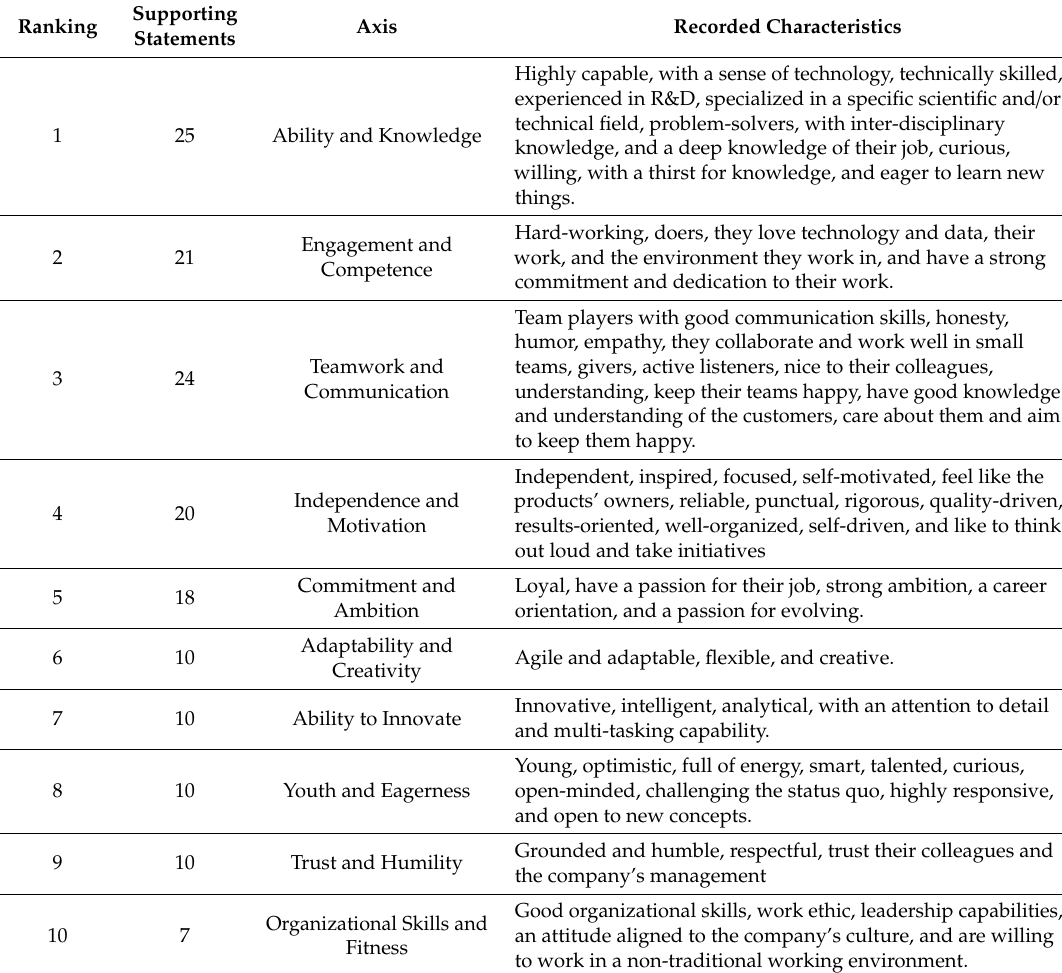
Table 7. Important Employee Characteristics for Technologically Innovative